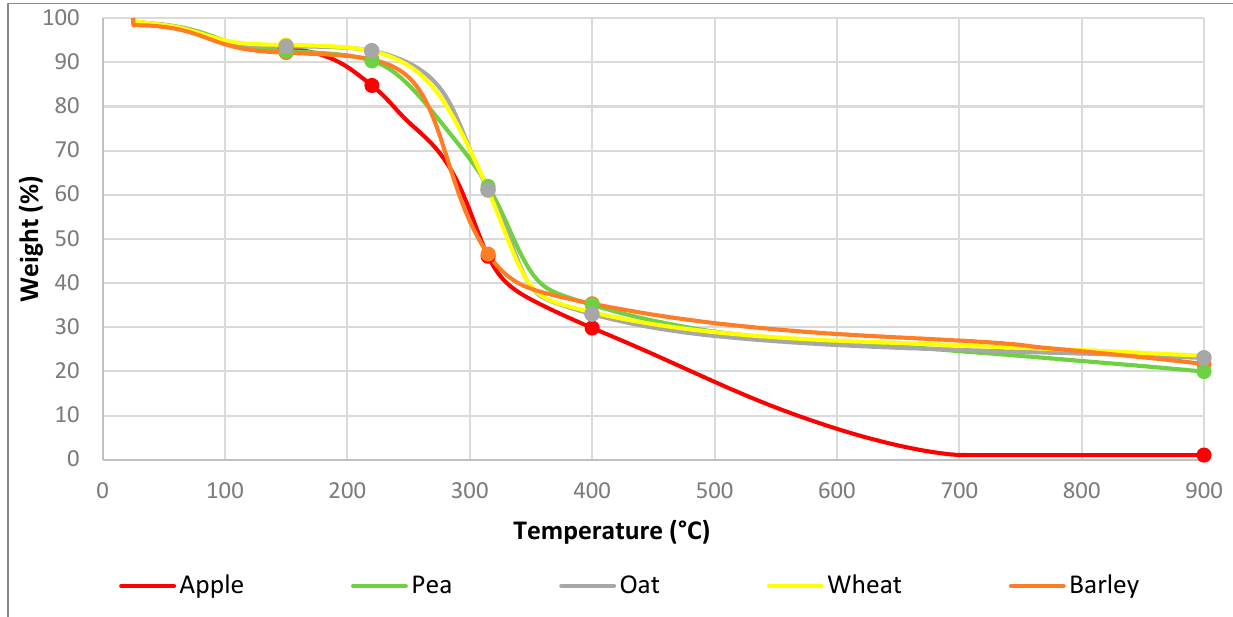
Figure 3. TGA characterisation of biomass.